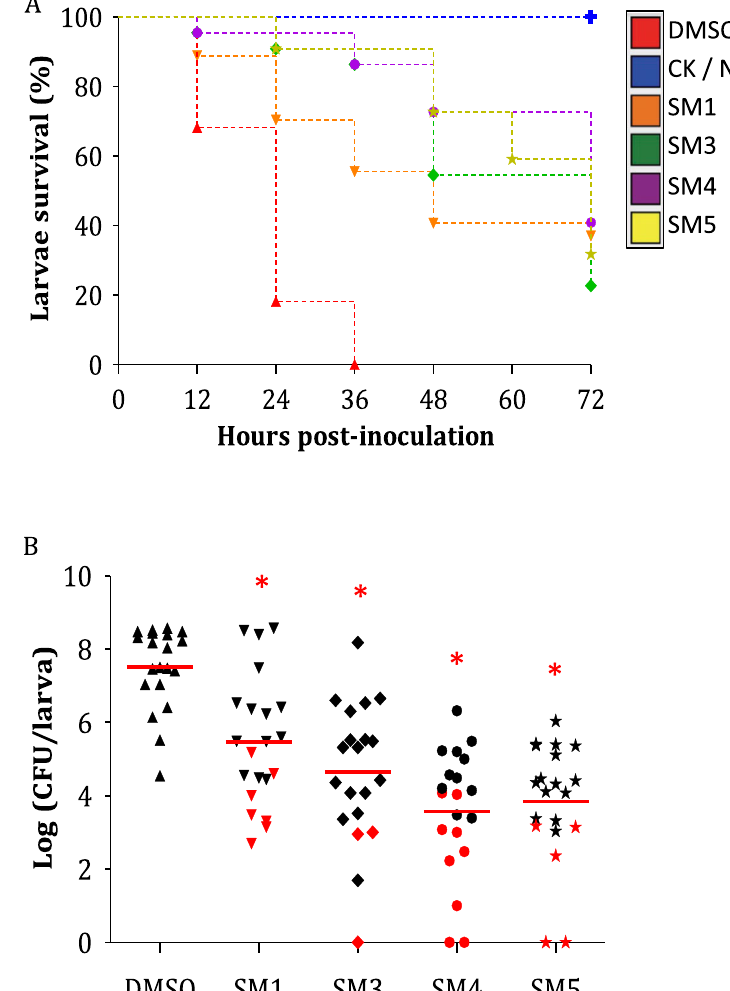
Figure 5. Effects of the small molecule (SM) treatments on Salmonella enterica subsp. enterica serotype Typhimurium infected Galleria mellonella . ( A ) Larva survival rate. Larva survival rate was monitored every 12 hrs for three days. Larvae not infected and not treated (NC), and infected larvae treated with 50 mg/kg chloramphenicol (CK) had 100% survival (blue line). ( B ) Bacterial quantification of Salmonella inside the larvae. Red dot: the larva was still alive after 72 hrs post-inoculation (HPI); black dot: the larvae that died during the experiment; n = 20; red line: mean; asterisk: internalized Salmonella population was significantly lower compared to the 1% dimethyl sulfoxide (DMSO) control (P <